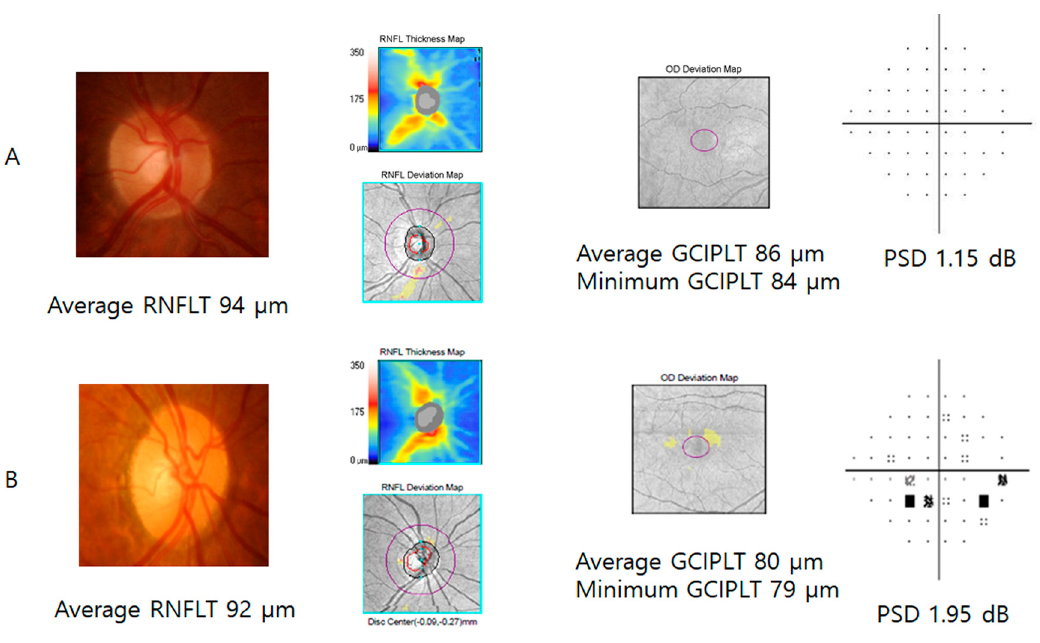
Figure 3. A sixty-three-year-old female with major depression ( B ) presented lower ganglion cell–inner plexiform layer thickness (GCIPLT) than a sixty-five-year-old female without depression ( A ). The patient with depression showed a higher pattern standard deviation (PSD = 1.95 dB) than the subject without it (PSD = 1.15